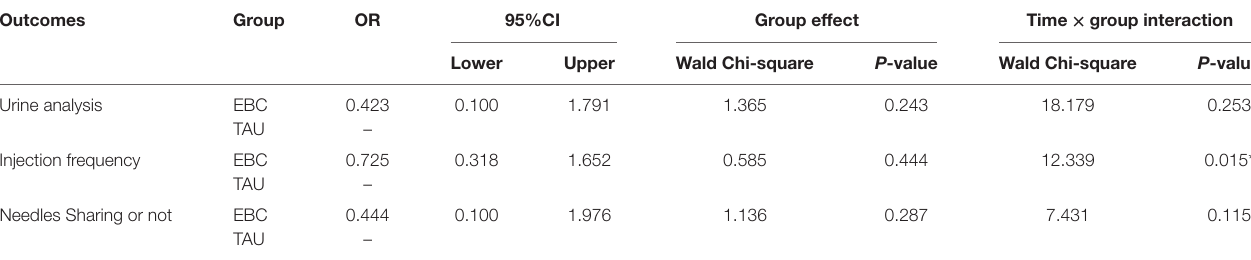
TaBlE 5 | Generalized estimating equation analyses for primary and secondary outcomes (categorical variables).